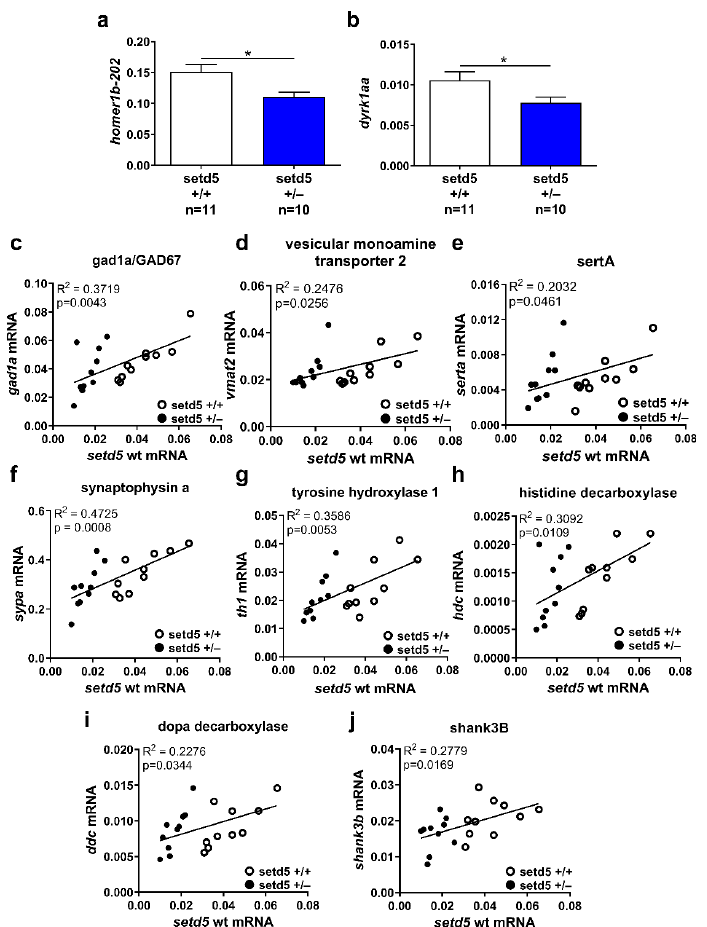
Figure 7. setd5 haploinsufficiency affects mRNA expression levels of synaptic regulators. ( a , b ) Ex- pression of homer1b-202 ( a ) and dyrk1aa ( b ) in setd5 +/+ and setd5 +/ − adult zebrafish brains, obtained by RT-qPCR analysis. The values are expressed as 2 −(ΔCt) , using bactin1 as the housekeeping gene. n = number of adult brains analyzed. Data are expressed as mean ± SEM. Statistical analysis was per- formed using a Student’s t -test. * p < 0.05. ( c – j ) Linear regression analysis between setd5 wild type mRNA level and gad1a/GAD67 ( c ), vesicular monoamine transporter 2 ( d ), sertA ( e ), synaptophysin a ( f ), tyrosine hydroxylase 1 ( g ), histidine decarboxylase ( h ), dopa decarboxylase ( i ), and shank3B ( j ) in setd5 +/+ (empty dots) and setd5 +/ − (full dots) adult zebrafish brains, obtained by RT-qPCR analysis. R 2 = coefficient of determination. A linear regression-fitting curve is shown.